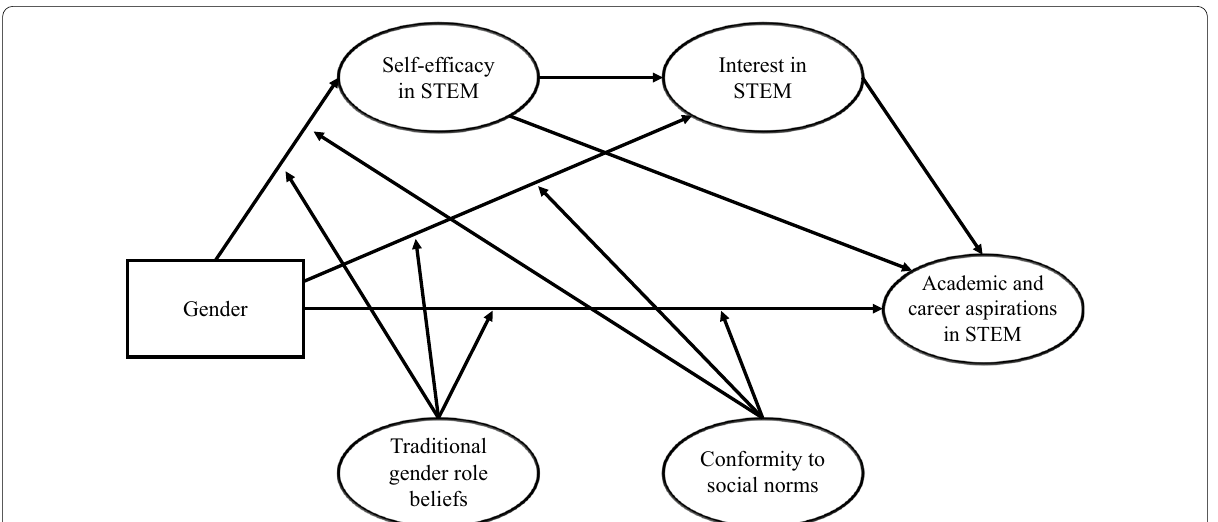
Fig. 2 Hypothesized moderated mediation model of gender differences in self-efficacy, interest, and academic and career aspirations in